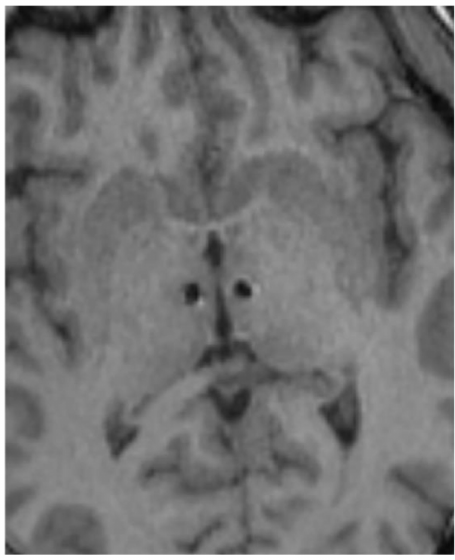
Figure 1. Axial T1-weighted magnetic resonance imaging (MRI) showing electrodes in the ventralis oralis / centromedian-parascicular nucleus of the thalamus (Voi-Cm / Pf) (1.5 Tesla).